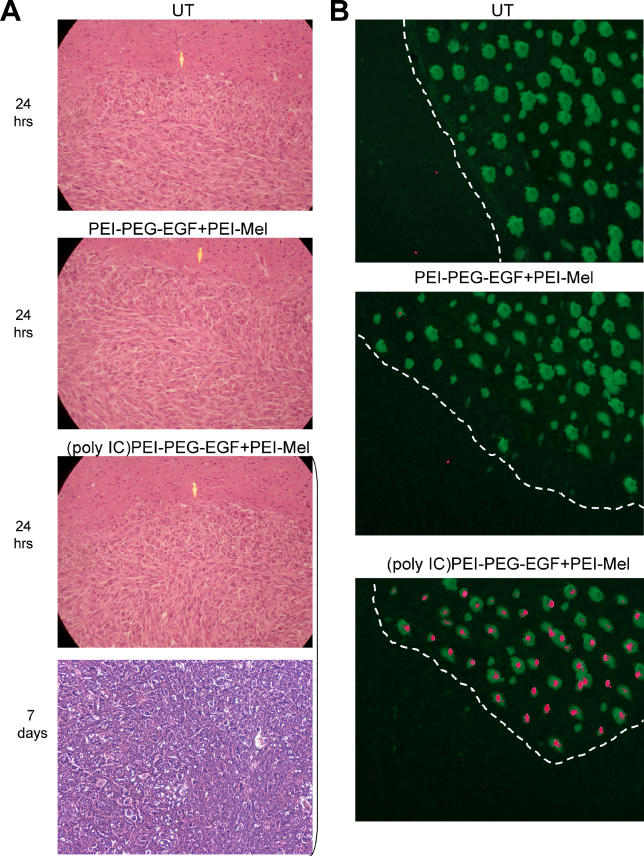
In Vivo Selectivity of the Approach(A) Pathological analysis of the brains. Intracranial tumors were established and treated as described in Methods. After 24 h, animals were sacrificed and ultrathin slices of the brains were prepared. Slices were stained with H & E and analyzed by light microscopy (20× magnification) for development of pathological signs and immune cell infiltration (yellow arrow). Bottom panel shows the example of slices from the brains treated with (poly IC)PEI-PEG-EGF+PEI-Mel in the experiment described in Figure 5A (7 d post-treatment).(B) Poly IC induces apoptosis in intracranial xenografts. Intracranial tumors were established and treated as described in Methods. Apoptotic death was detected using Cell Death Detection kit-TMR Red (Methods). White dashed lines represent borders of the tumors.